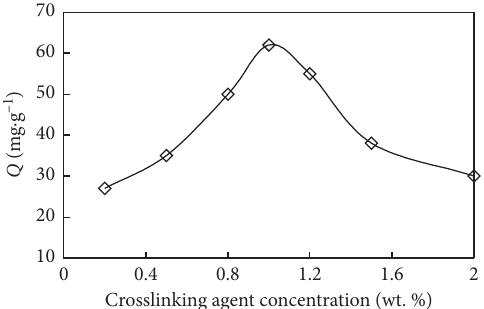
Figure 5: Effects of the neutralization degree on Cu 2+ absorption